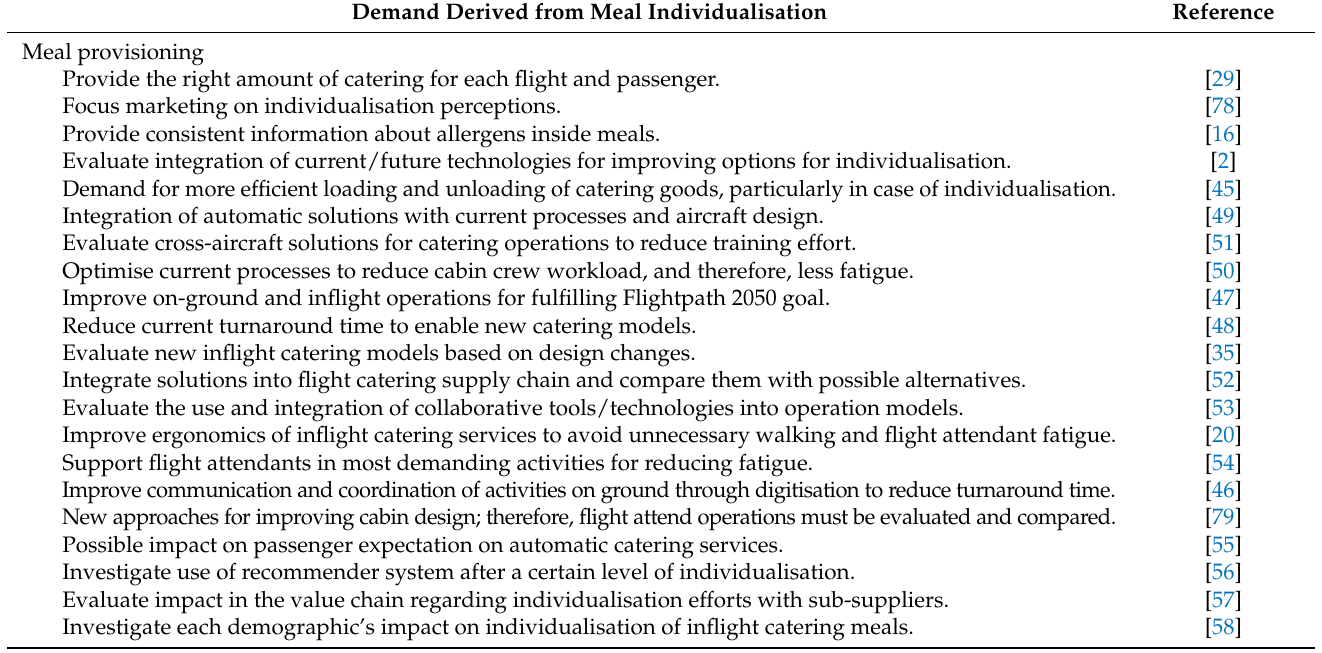
Table A2. Summary demand derived from inflight meal individualisation after the literature